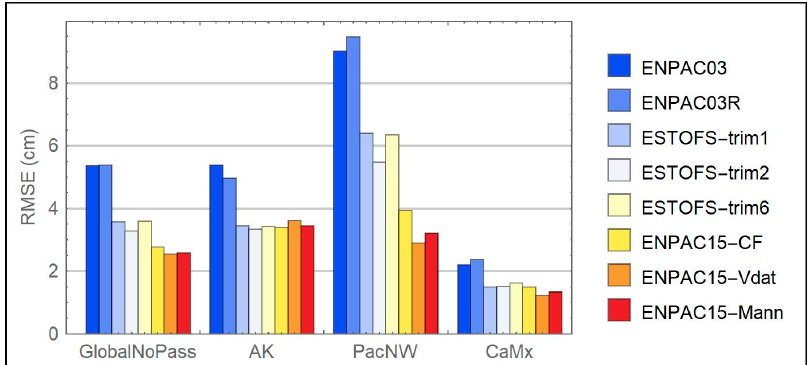
Figure 7. Comparison of regional mean root mean square errors using the 165 wet stations (neglect the stations near inside passages) for all eight study simulations summarized in Table 4.